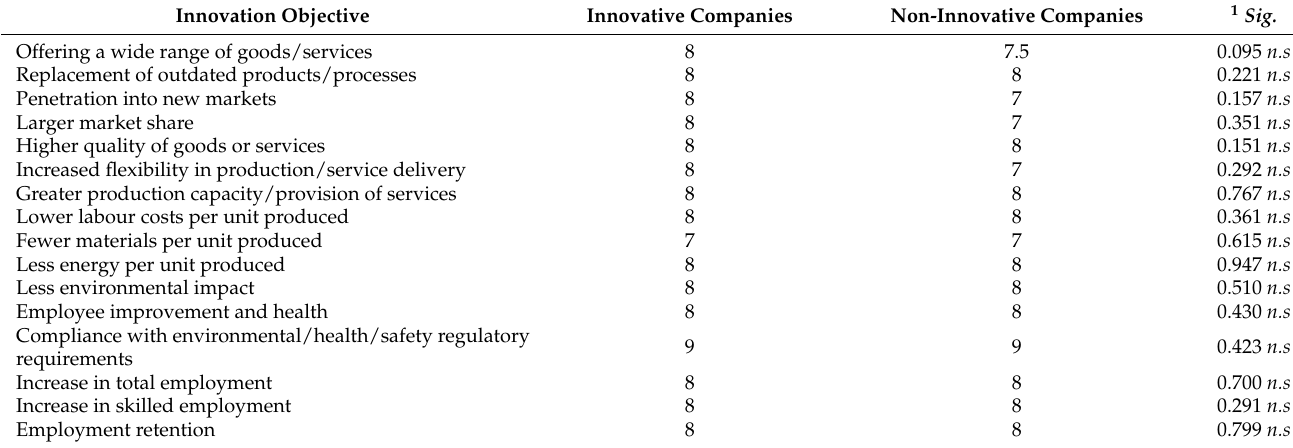
Table 4. Mann–Whitney test: innovation